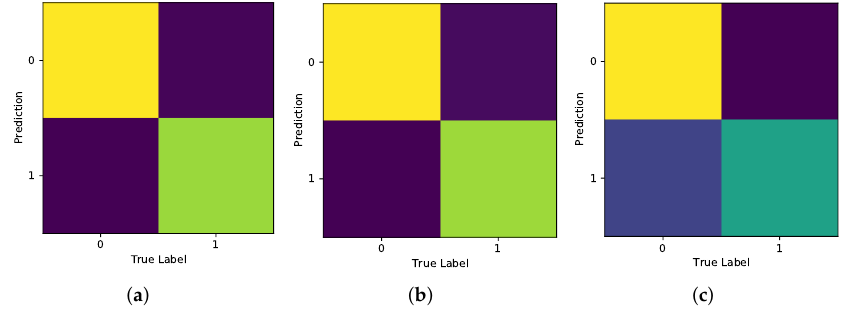
Figure 20. Model C Confusion Matrices. ( a ) E1. ( b ) E2. ( c ) E3.